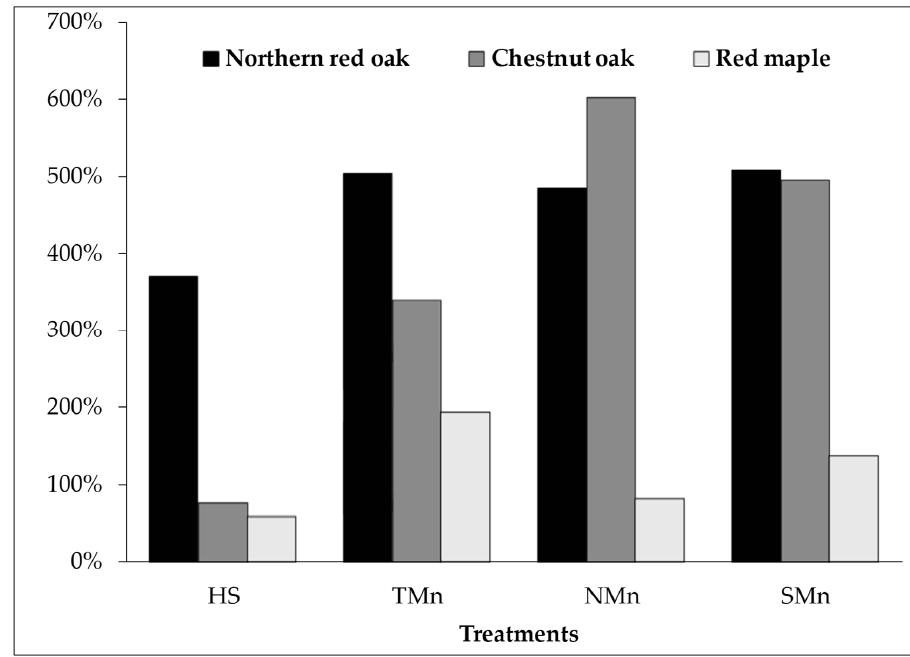
Figure 1. Percent changes based on the mean overall seedling size (basal diameter squared × total height) compared to the control for each treatment by species. The treatments are: HS = Hoagland solution; TMn = manganese (MnCl 2 .4H 2 O) + Hoagland solution; NMn = nanoparticle manganese (Mn(OH) 2 ) + Hoagland solution; and SMn = suspension manganese (Mn(OH) 2 ) + Hoagland solution. The Mn fertilizer improved the oak and maple biomass compared with the control and the N, P, and K additions with the HS treatment. The HS treatment increased the total seedling biomass for northern red oak, chestnut oak, and red maple by 4.92 g, 0.21 g, and 0.19 g, respectively, compared to the control. However, the average increases in total biomass for the Mn treatments were 5.35 g, 1.88 g, and 0.46 g for northern red oak, chestnut oak, and red maple, respectively, compared to the control. These treatments caused a redistribution of biomass among the seedling components. The root system and foliage biomass comprised 52% and 28%, respectively, for chestnut oak in the control. The HS treatment changed this distribution to 40% and 40% for the root system and foliage, respectively. The Mn treatments caused this distribution to become more heavily to foliage as the average distribution percentage was 29% and 46% for the root system and foliage, respectively. A similar trend was observed for northern red oak as the distribution of dry biomass for the root system and foliage in the control was 48% and 28%, respectively. The HS treatment changed the distribution of root and foliage biomass to 37% and 36%, respectively. The average redistribution of the root and foliage biomass in the Mn treatments was 37% and 45%, respectively.